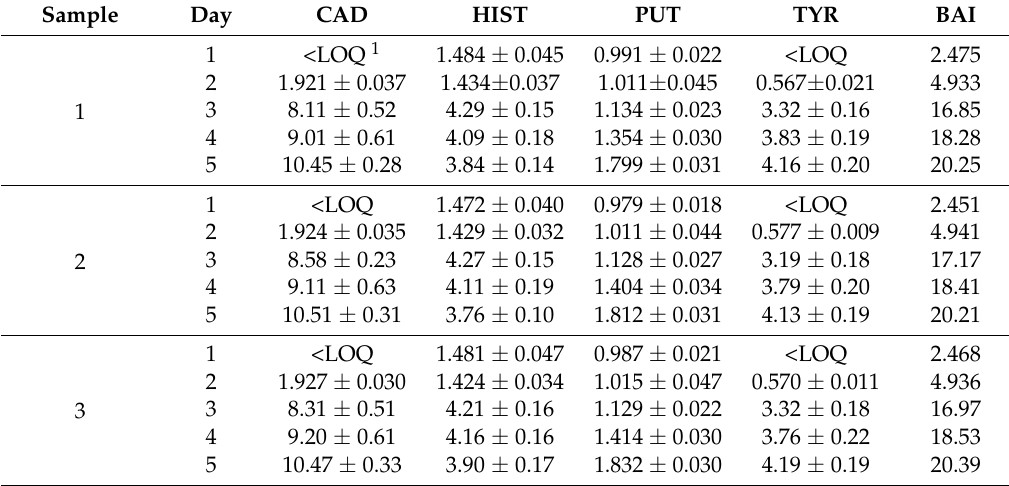
Table 1. Concentration (mg/kg, average ± mean square error (MSE)) of cadaverine (CAD), histamine (HIST), putrescine (PUT), and tyramine (TYR) in three samples from the first batch of chicken breast muscle, analyzed daily, and the corresponding value of the biogenic amines index